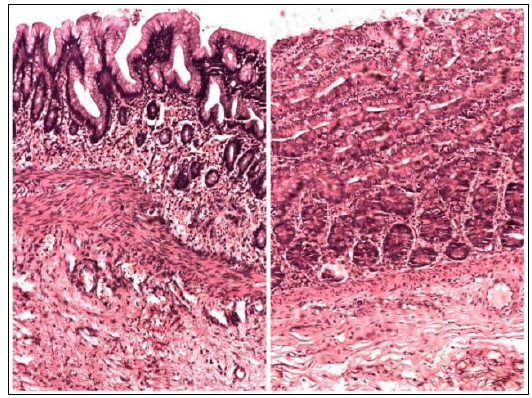
Figure 4: Photomicrograph showing histopathology of duplica- tion cysts revealing lining of intestinal